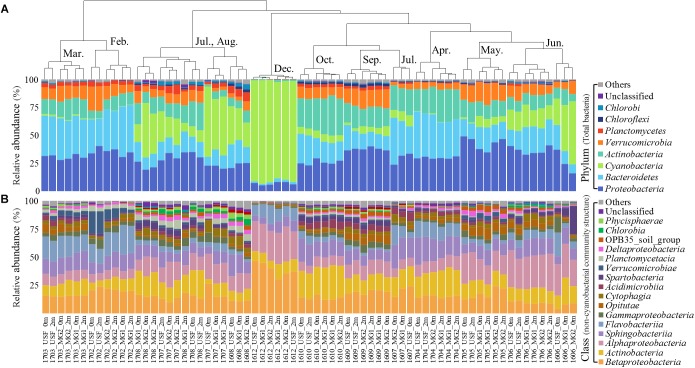
Relative abundance of (A) total bacterial community structure (phylum level) and (B) non-cyanobacterial community structure (class level). The dendrogram shows the clustering of the OTU data (Bray–Curtis similarity measure). Taxa with <0.5% average abundances are pooled together and shown as “Others.” Samples are labeled by a four-number code indicating the year and month of sampling (in YYMM format).